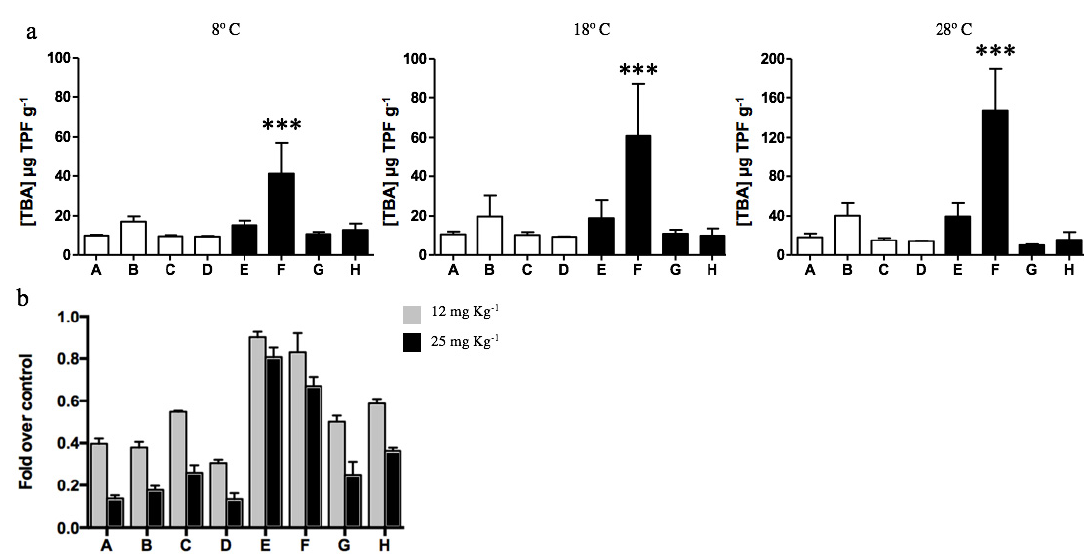
Figure 4. Dehydrogenase activity of soil samples determined at different temperatures. ( a ) Total biological activity (TBA) measured by TPF g − 1 generated in non-exposed (white bars; A, B, C, and D) and diesel-exposed soils (black bars; E, F, G, and H). The assay was performed at 8, 18, and 28 ℃ . *** Represents significance with a p < 0.0001. ( b ) Fold decrease on CFUs g-1 determined on soils exposed to 12 (gray bars) and 25 mg kg-1 of cadmium (black bars) at 28 ℃ . CFUs g-1 determined in the absence of cadmium correspond to 100%.”.